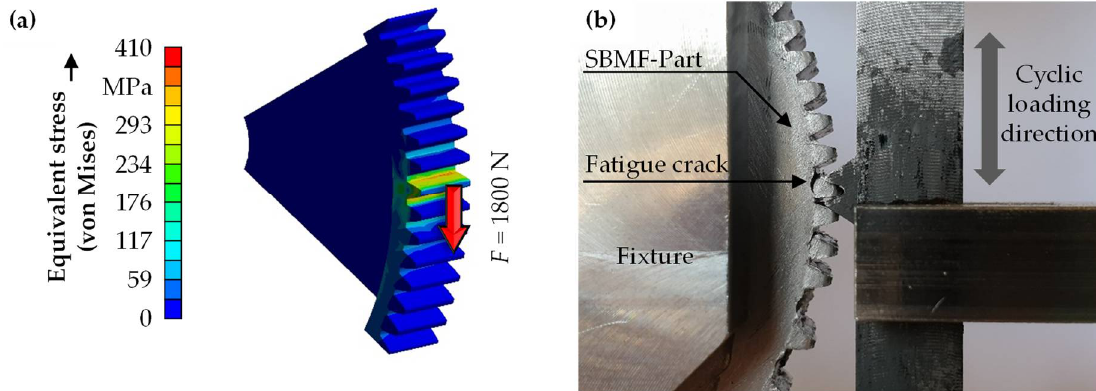
Figure 14. ( a ) Calculated von Mises stress for a service load of 1800 N and ( b ) the test setup for the fatigue tests.